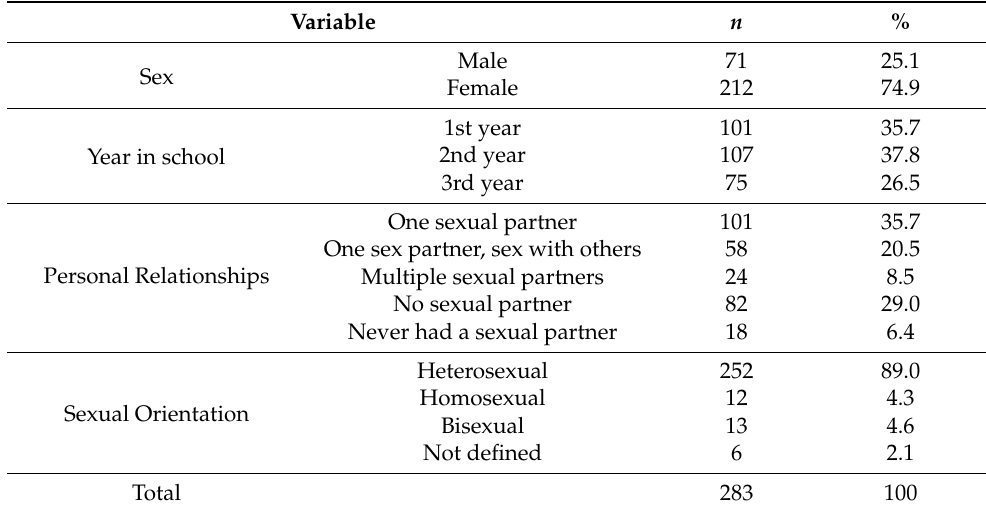
Table 1. Characteristics of the